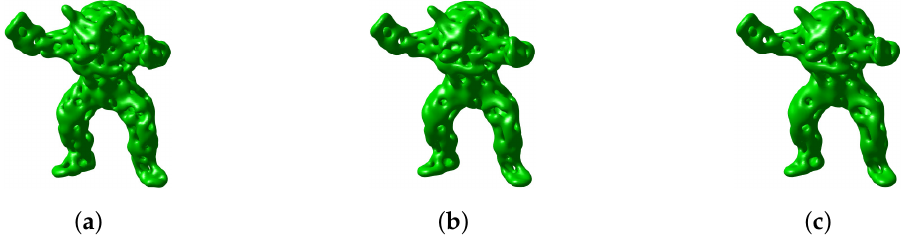
Figure 10. ( a – c ) are snapshots of phase separation with average concentration function Equation (13) on the Stanford Armadillo at t = 40 ∆ t , 60 ∆ t , and 80 ∆ t , respectively. Moreover, 3D printed models of Figures 9c and 10a can be printed as shown in Figure 11.